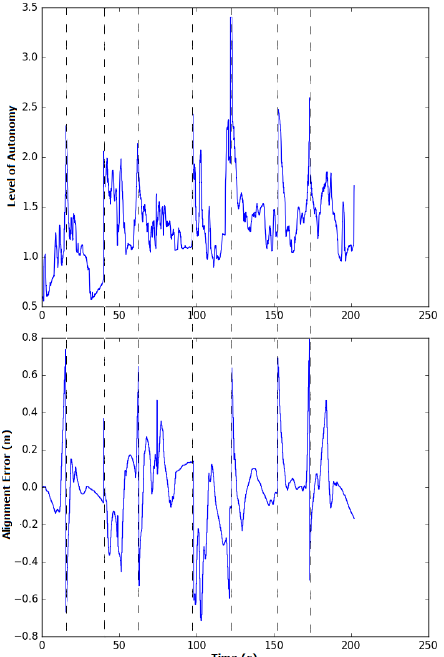
Figure 28. Autonomy and alignment error during the sliding autonomy experiment. The panel above shows the output of the fuzzy controller during the experiment, representing the level of autonomy. The panel below shows the alignment error. The dashed lines indicate the instances when there were spikes in the errors and in the level of